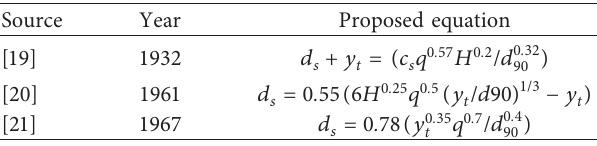
Figure 9: Comparison of the longitudinal scour profiles at three discharges and an opening ratio of 1 for three block geometries.